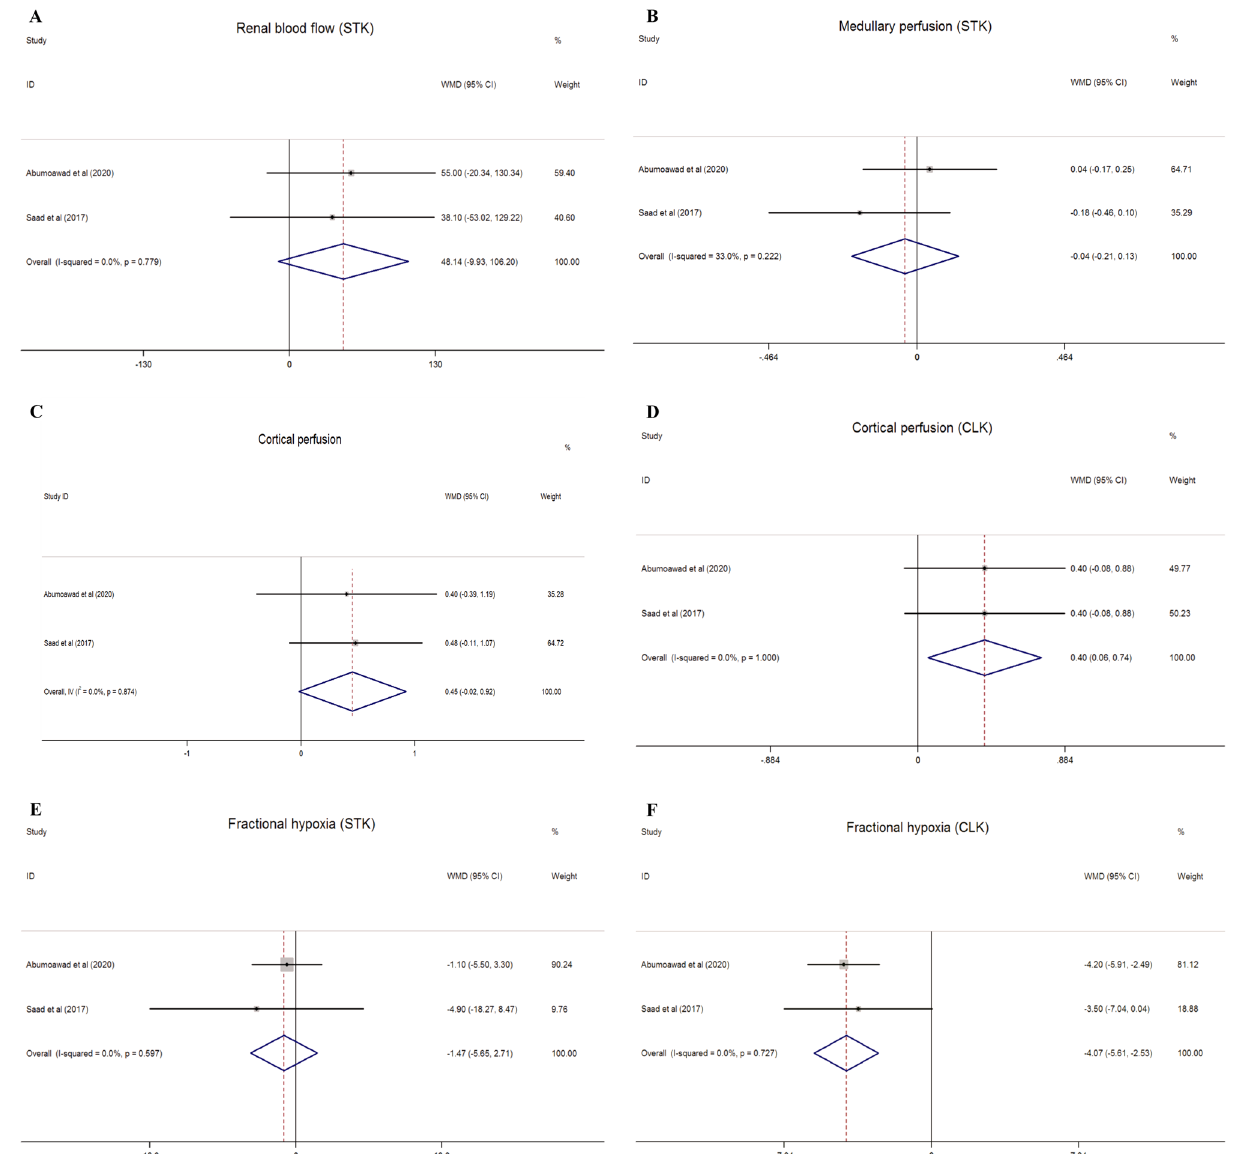
Figure 5. The effect of MSC therapy on renal blood flow of stenotic kidney ( A ), medullary perfusion of stenotic kidney ( B ), cortical perfusion of stenotic kidney ( C ) and contralateral kidney ( D ) as well as fractional hypoxia of stenotic kidney ( E ) and contralateral kidney ( F ) in clinical